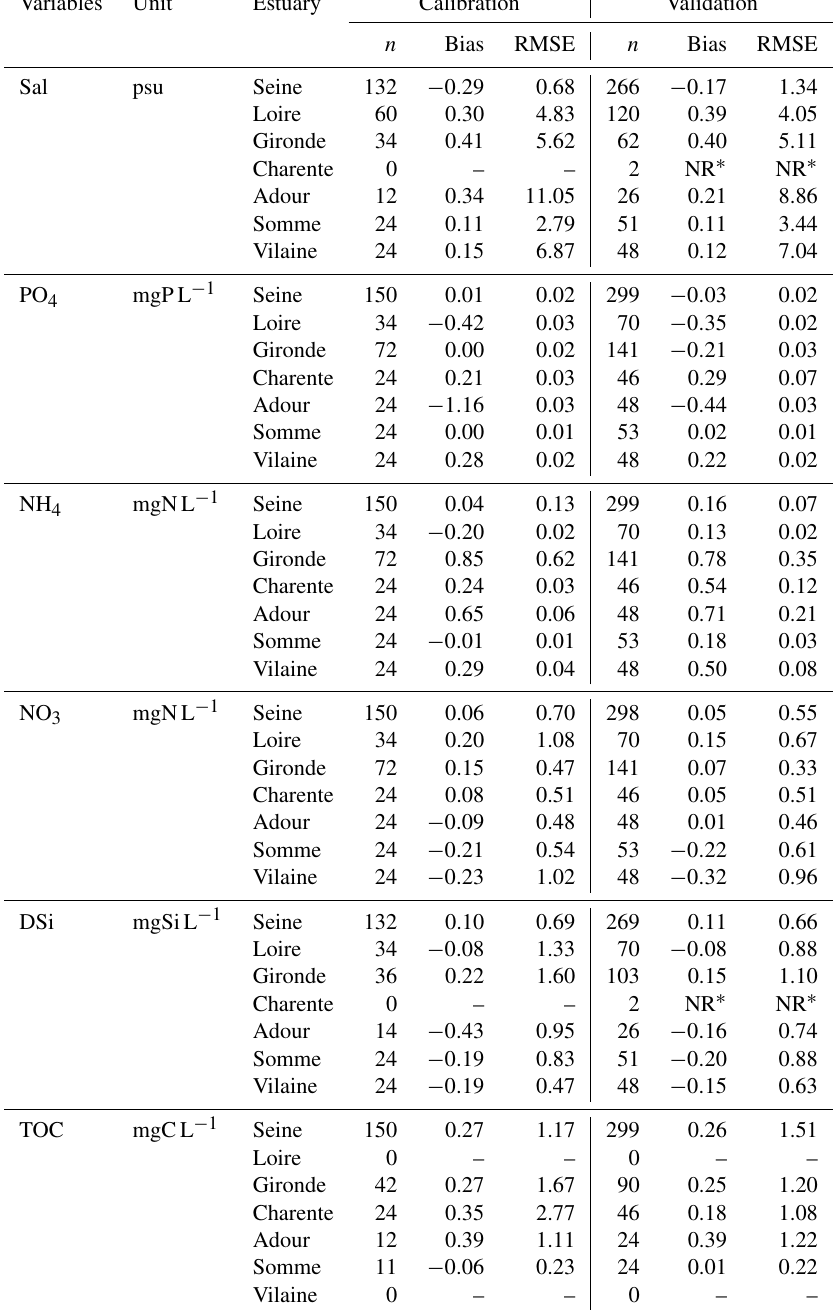
Table 7. Bias and root mean square error (RMSE) for salinity (Sal), phosphate (PO 4 ), ammonia (NH 4 ), nitrate (NO 3 ), dissolved silica (DSi), and total organic carbon (TOC) for the Seine, Loire, Gironde, Charente, Adour, Somme, and Vilaine